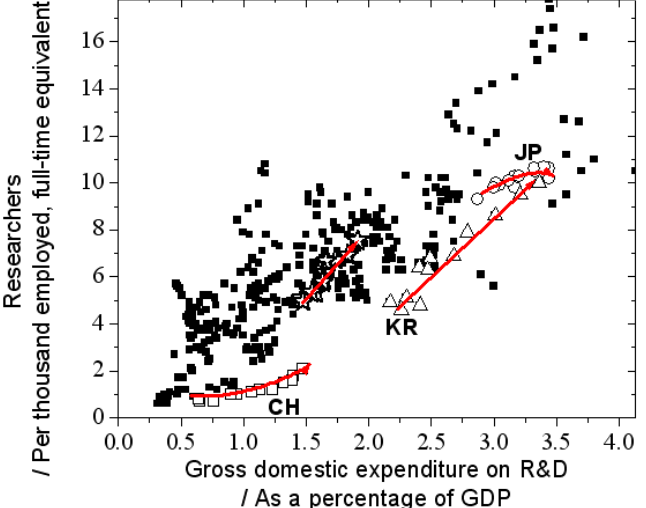
Figure 11. GERD versus total number of researchers in full-time equivalents (FTE) for China (CH = (cid:0) ) Korea (KR = Δ ) and Japan (JP =  ) between 1997 and 2009. The star indicates the overall mean of the data set in the world between 1997 and